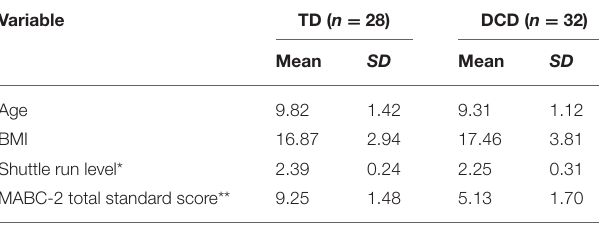
TABLE 2 | Characteristics of TD and DCD groups at the start of the training.